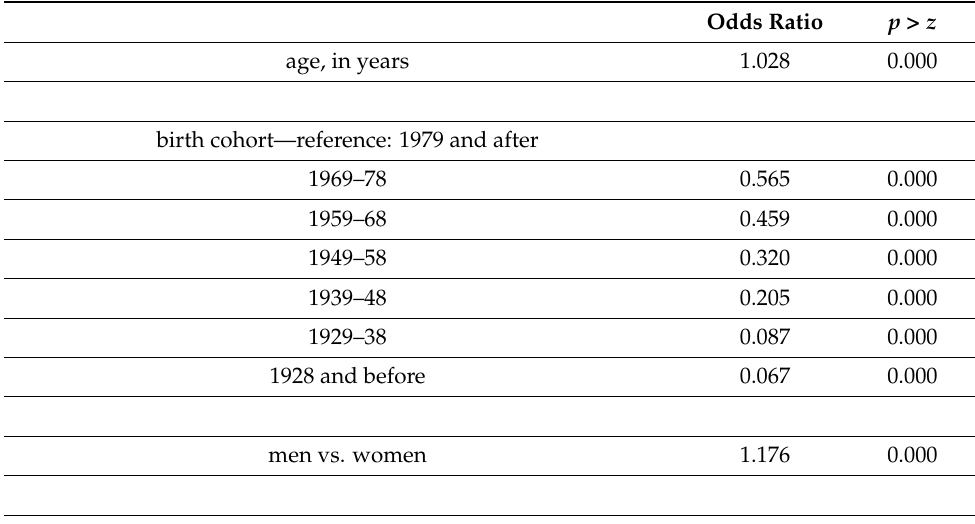
Table 2. Non-affiliation—GEE logistic regression